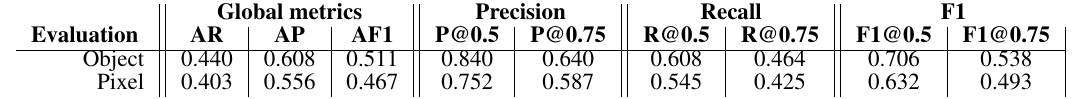
Table 3. Global evaluation metrics. AR, AP and AF1 are computed averaging values obtained in IoU 0.5 to 0.95 (cf. x-axis in Fig. 9). level is increased, meaning that, also considering precision